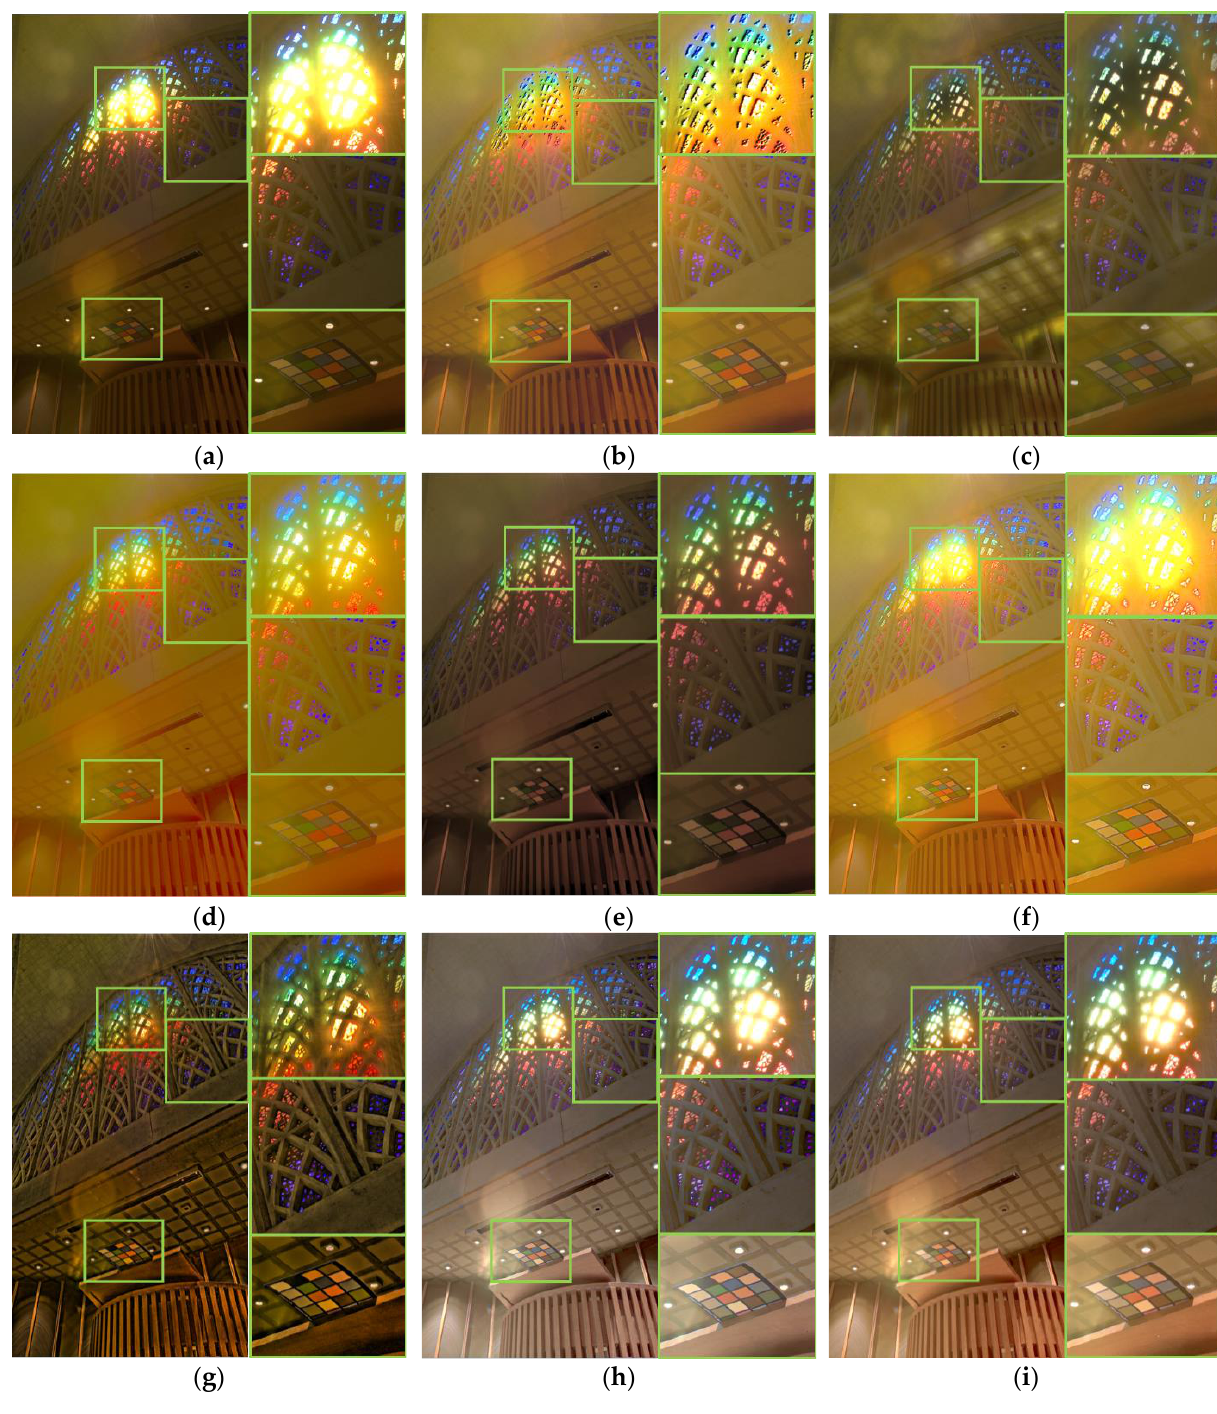
Figure 9. Rendering results of each method for HDR scene #2; ( a ) input image with Gamma tone mapping for visualization; ( b ) Banterle; ( c ) Bruce; ( d ) Reinhard; ( e ) Liang; ( f ) Li; ( g ) Shibata; ( h ) iCAM06; ( i ) proposed method.